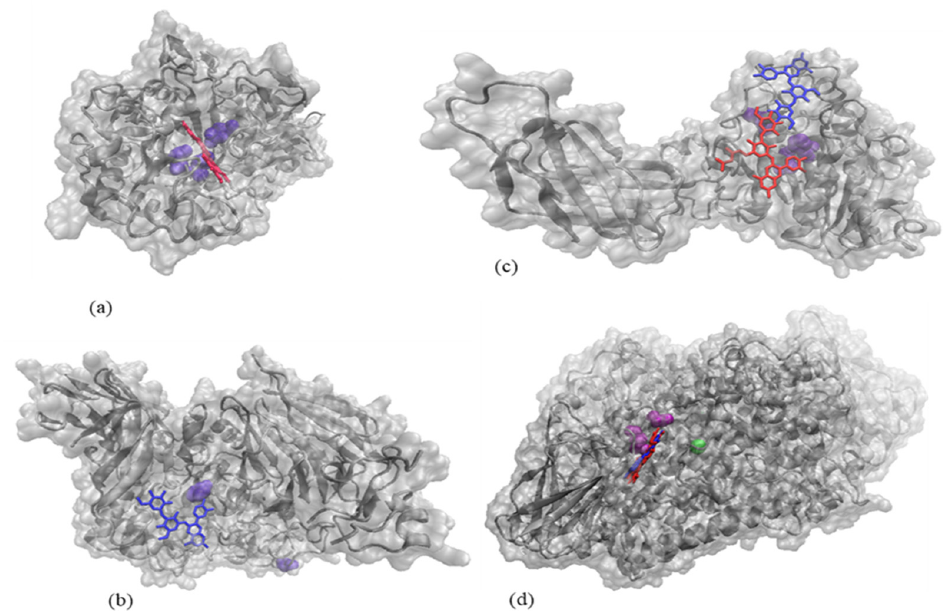
Figure 3. The results of the molecular docking tests showing the complexes formed by α -amylase ( a ) α -glucosidase ( b ), lipase ( c ), and LOX ( d ) shown in silver, with cyanidin 3- O -laminaribioside and/or cyanidin 3- O -(6 ′′ -malonyl-laminaribioside) represented in Licorice style in blue and red, respectively. The catalytic amino acids establishing contacts with the ligands are represented in purple in Van der Waals style. Images were prepared using VMD software [61].